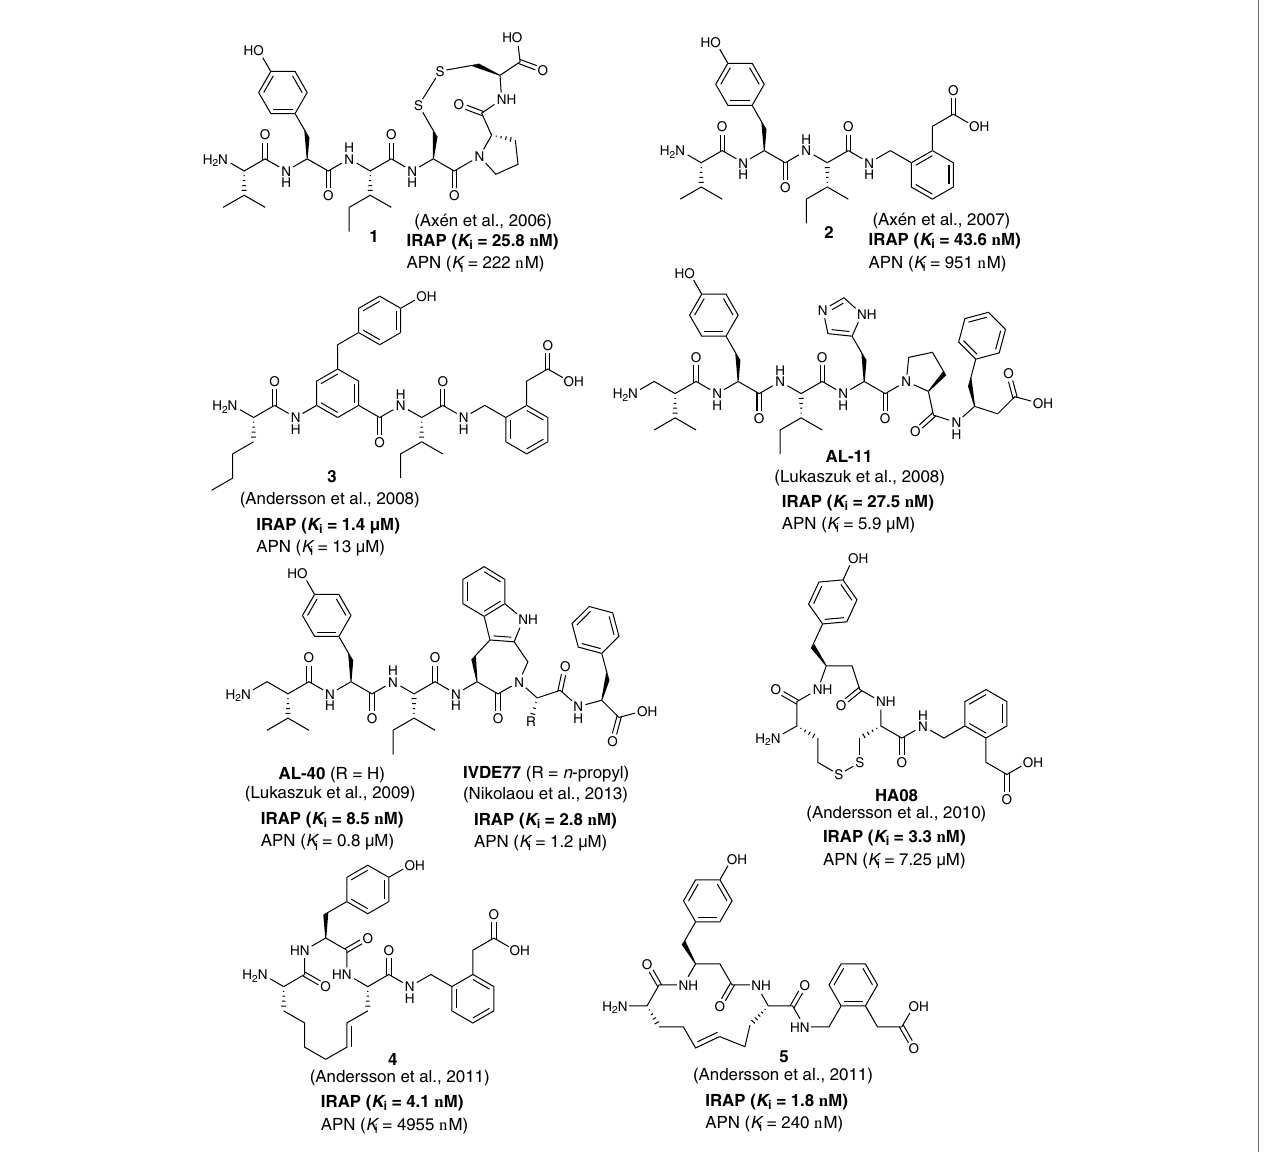
FIGURE 1 | Chemical structures of AngIV-based inhibitors of IRAP 1 - 5 , AL-11 , AL-40 , IVDE77, and HA08 . K i values for IRAP and APN are given in all